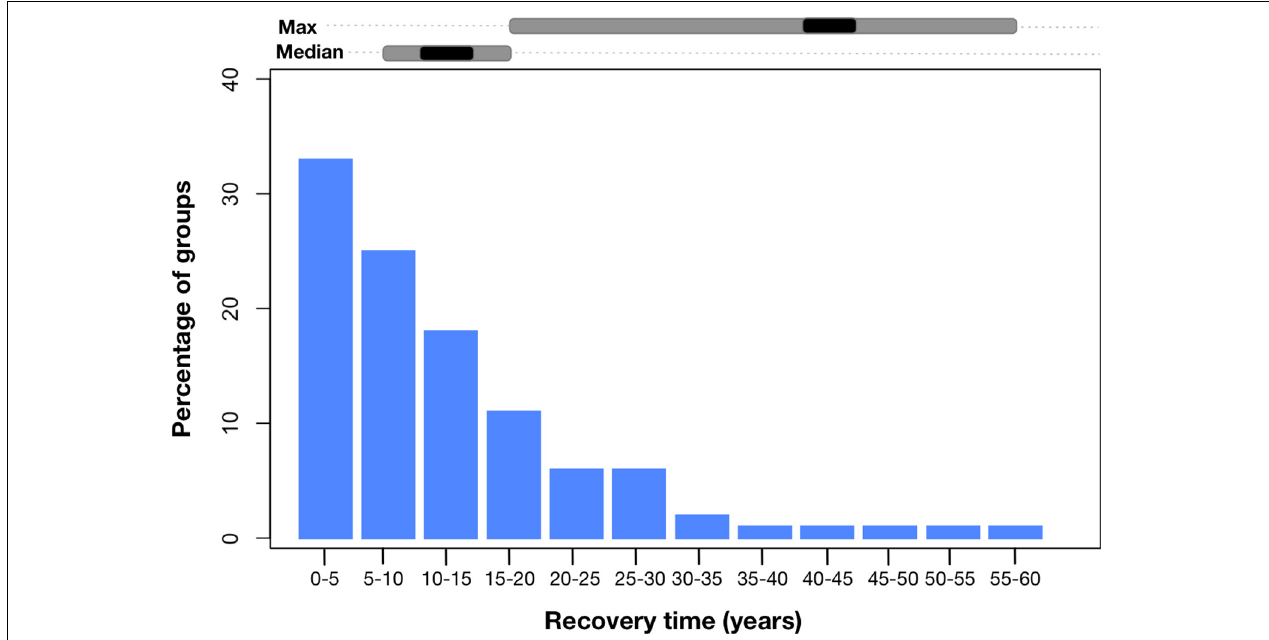
FIGURE 3 | Distribution of recovery times (across all groups in all models). The spread of the median and maximum ranges of recovery times at a system level are shown in gray bars above the plot, with the median across systems shown in black.